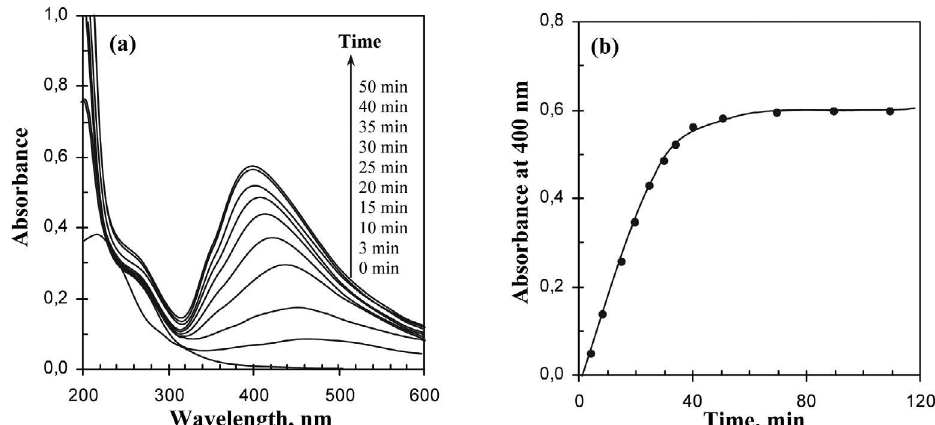
Fig. 3. The UV–Visible spectra of silver nanoparticles as a function of time (a); Absorbance at 400 nm versus time plot for the silver nanoparticles formation